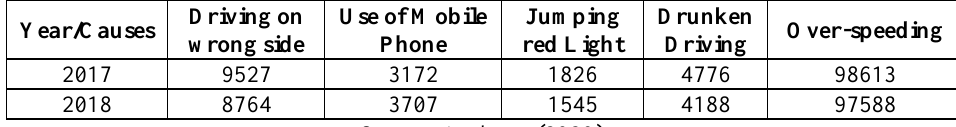
Table 11: Road accident deaths based on traffic rule violation.